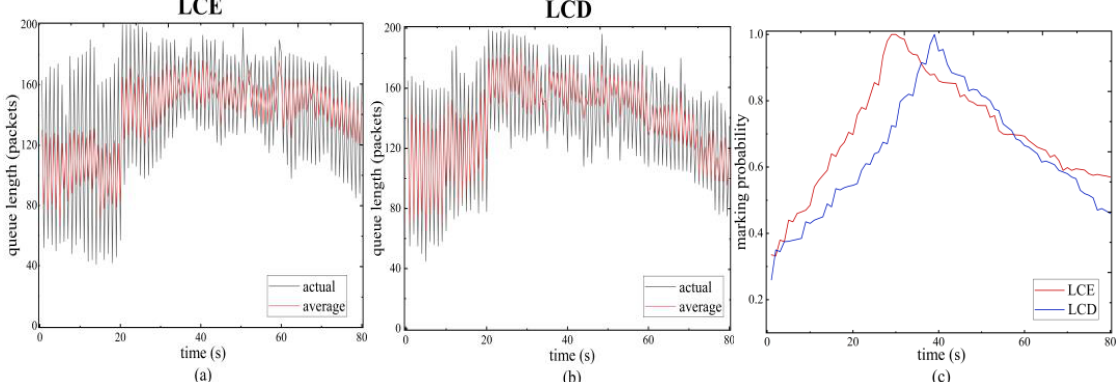
Figure 8. Comparison of queue length and marking probability under BLUE between LCE and LCD. ( a ) the actual and average queue length of under LCE; ( b ) the actual and average queue length of under LCD; ( c ) the marking probability under LCE and LCD.